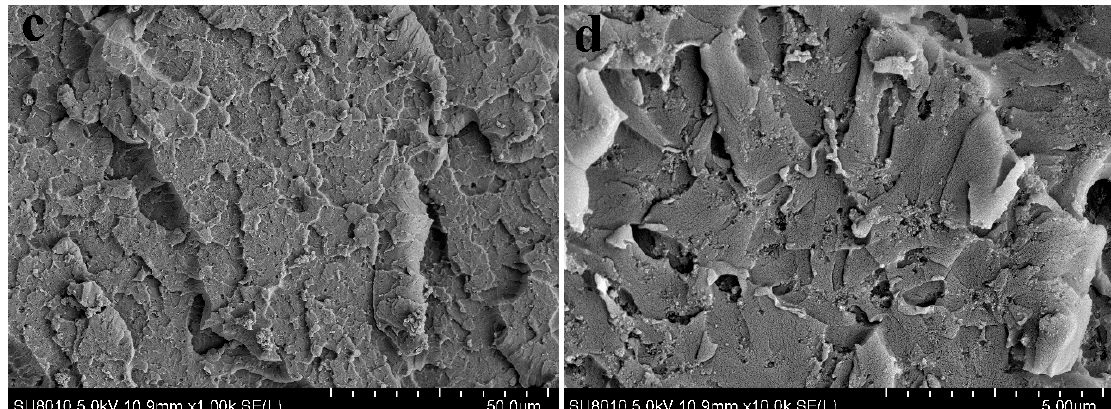
Figure 8. SEM morphologies of impact fractures of epoxy composites: ( a , b ) Epoxy composites containing u-silica (silica20); ( c , d ) Epoxy composites containing IL-silica (IL-silica20).